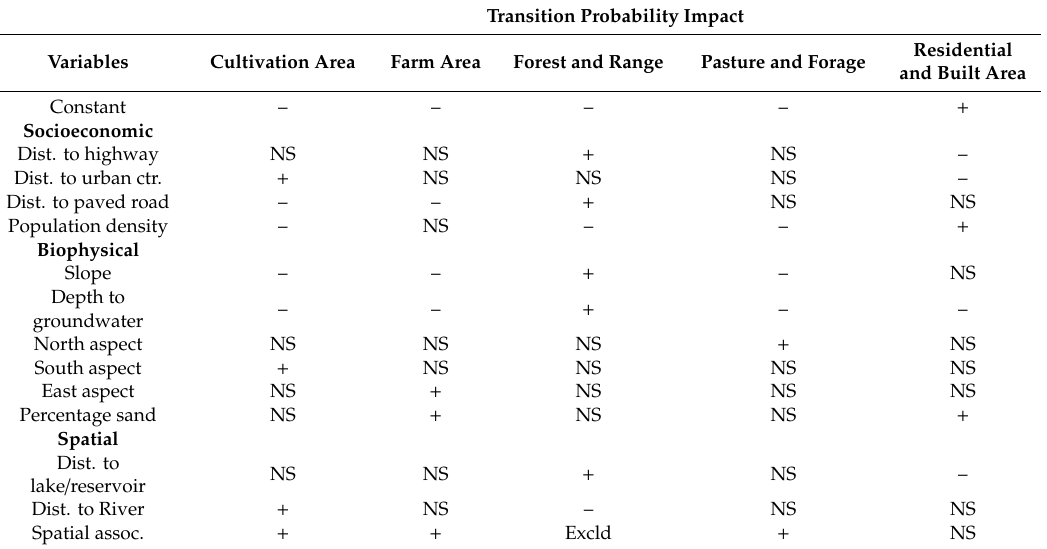
Table 1. Direction of transition probabilities for exogenous driving variables included in the logistic regressions used to calibrate the CLUE-S